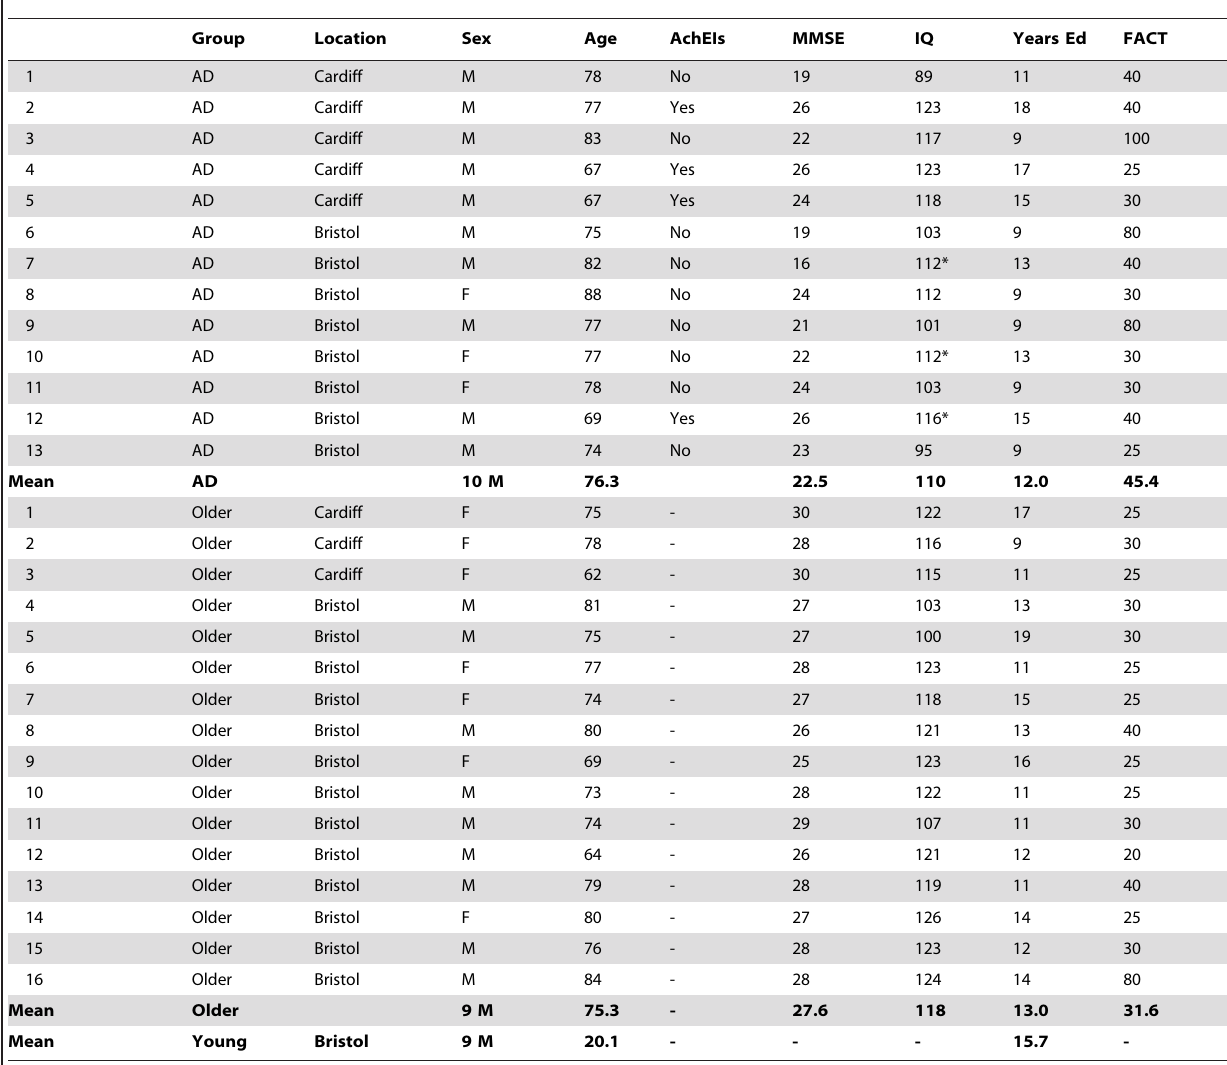
Table 1. Clinical and demographic details for all older